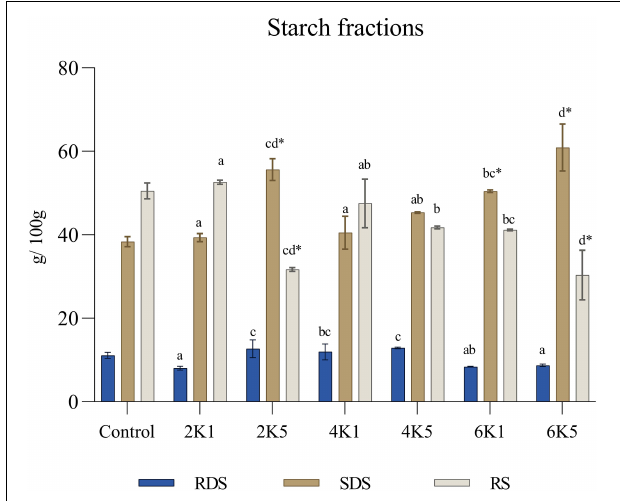
FIGURE 6 | Rapidly digestible starch (RDS), slowly digestible starch (SDS) and resistant starch (RS) in the control and HPP chickpea samples. Bars bearing different letter for the same fraction are significantly ( p < 0.05) different. Bars bearing * for the same fraction are significantly ( p < 0.05) different than the control (where, 2K1 = 200 MPa, 1 min; 2K5 = 200 MPa, 5 min; 4K1 = 400 MPa, 1 min; 4K5 = 400 MPa, 5 min; 6k1 = 600 MPa, 1 min; and, 6K5 = 600 MPa, 5